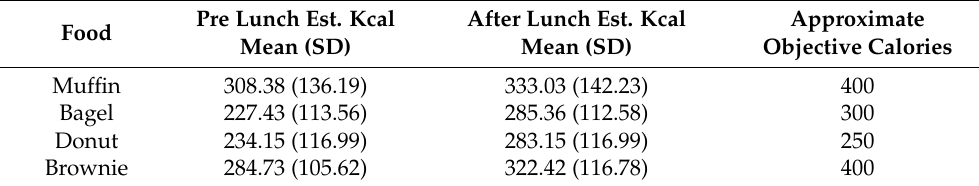
Table 2. Estimated Calories are Lower Before (vs. After) Lunch (N =